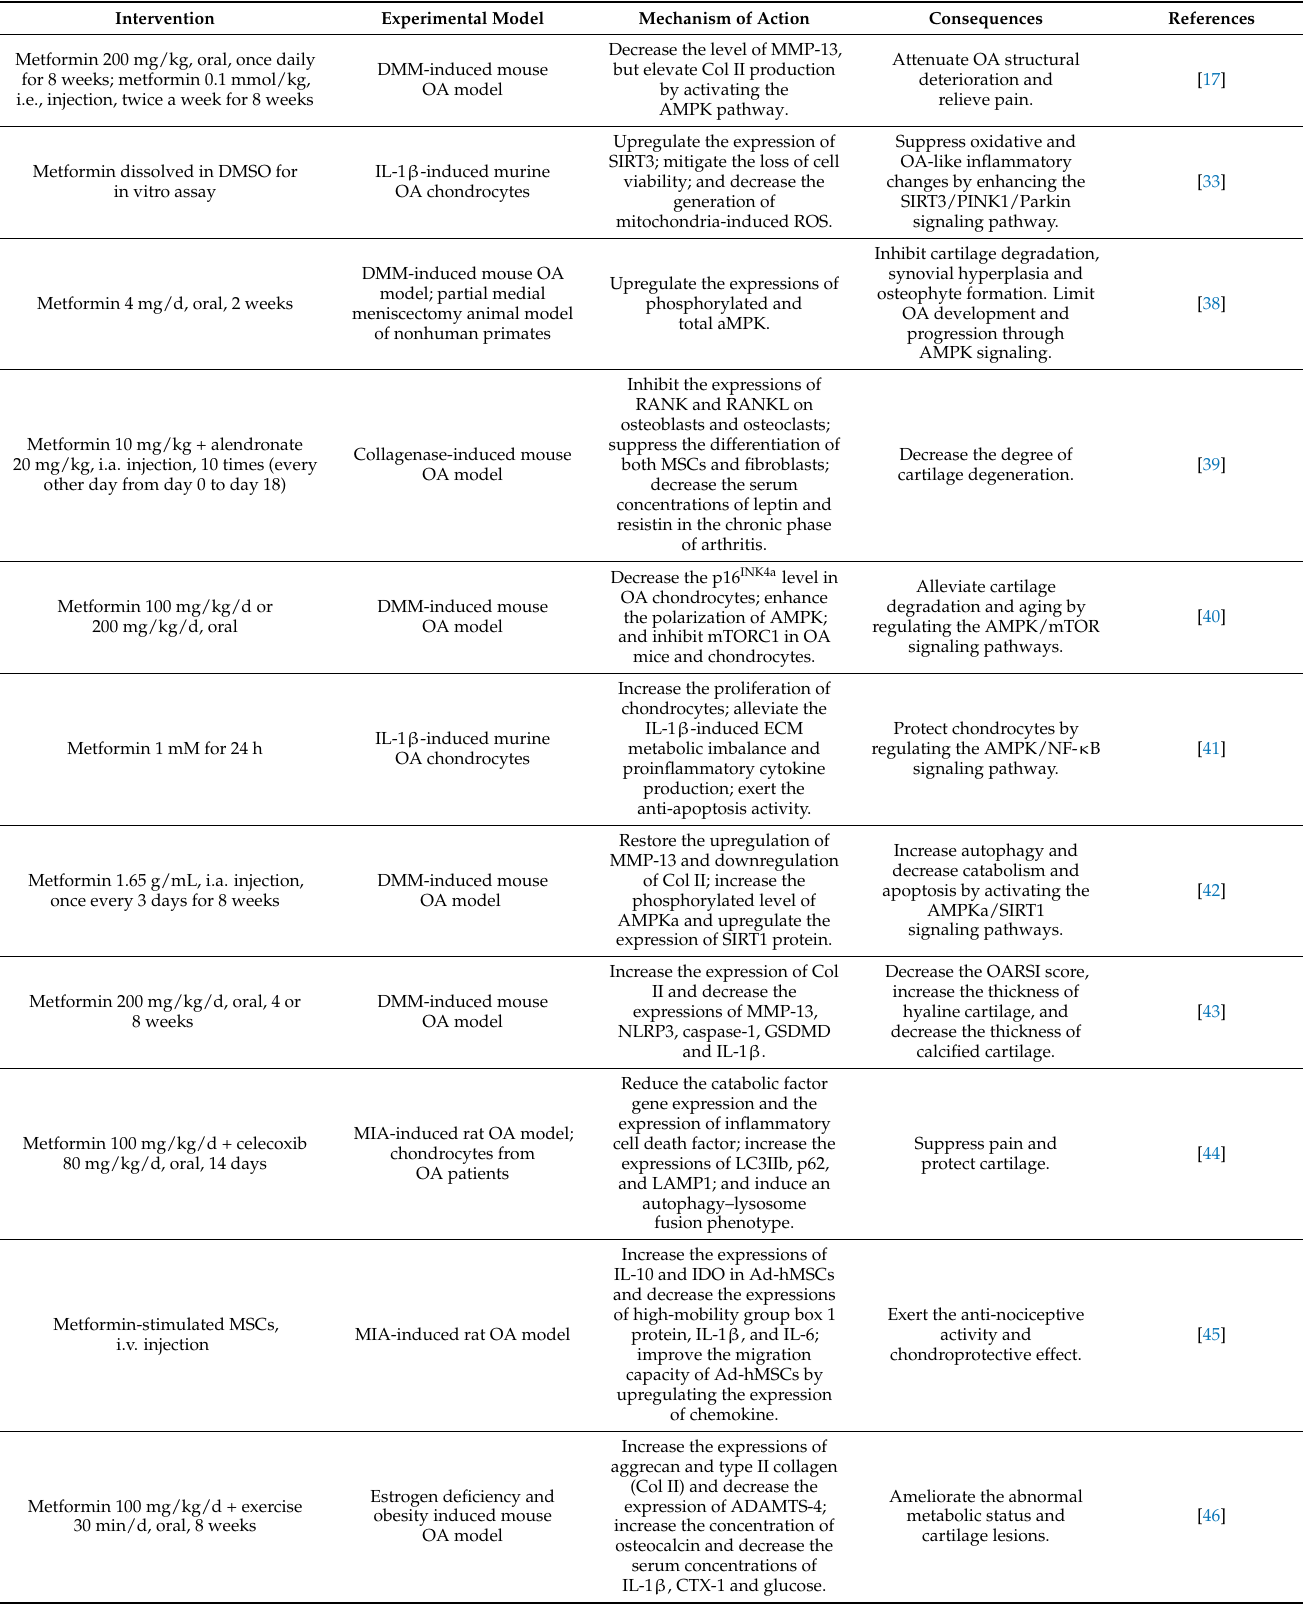
Table 1. Roles of metformin in